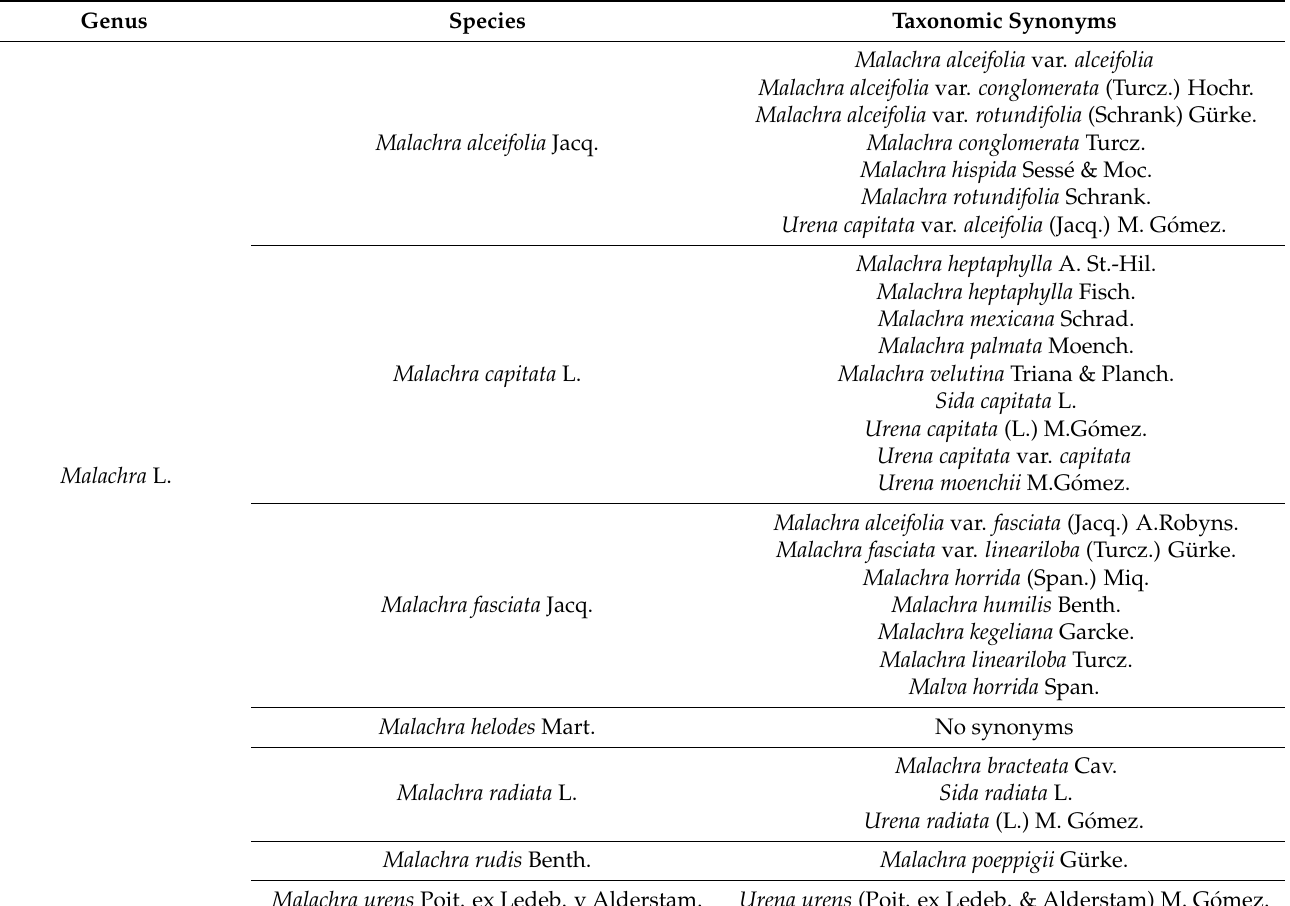
Table 2. Taxonomic synonyms for species of the genus Malachra L. Genus